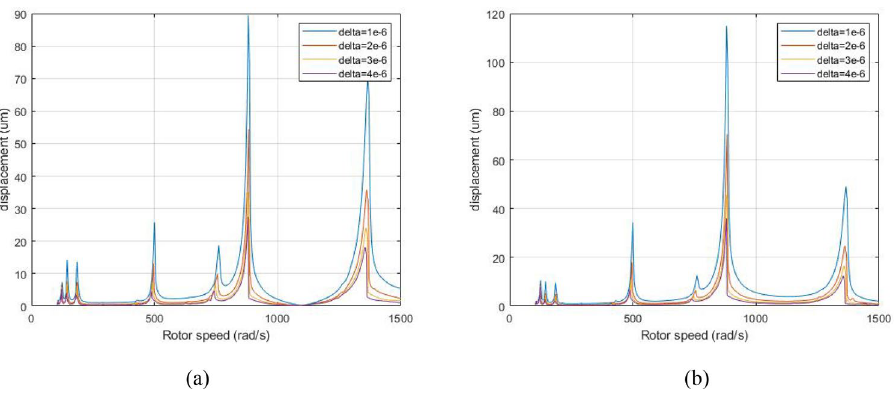
Figure 18. Amplitude-frequency response curve (λ = 1. 75, F 0 = 100, A max = 200) ( a ) LP rotor ( b ) HP rotor.